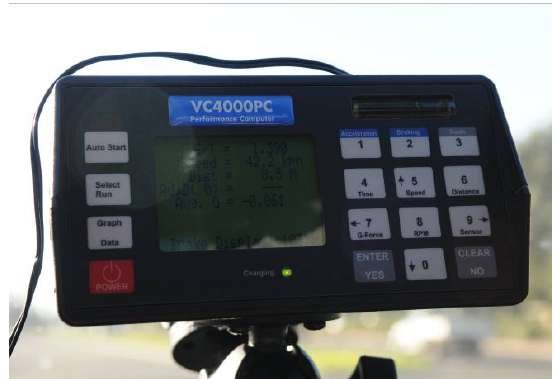
Fig. 4. Vericom VC4000PC brake test computer used to determine tyre/road friction